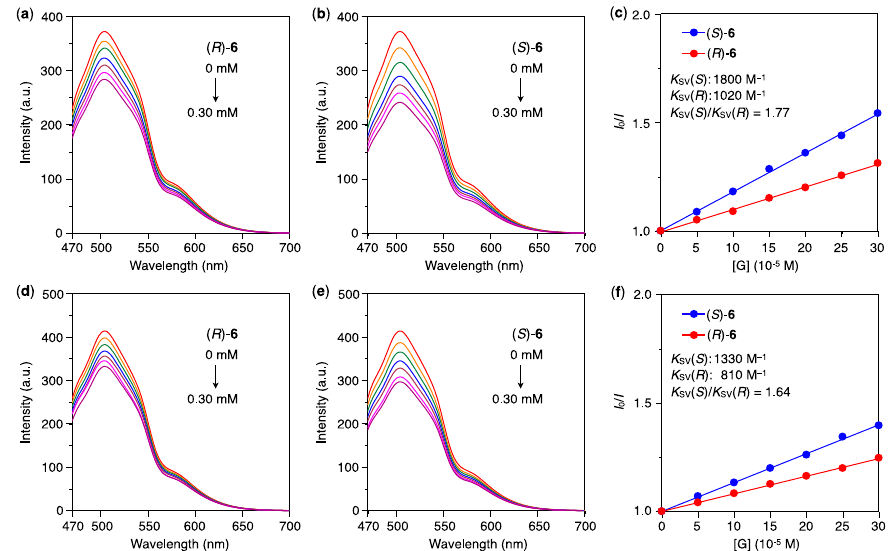
Figure 5. Fluorescence spectra of Am- 1b ( a , b ) and CyD- 1b ( d , e ) upon the addition of various amounts of ( R )- 6 ( a , d ) and ( S )- 6 ( b , e ) in hexane/THF (90/10, v / v ) at room temperature. [Glucose unit] = 1.0 × 10 − 5 M, [ 6 ] = 0–0.30 mM, λ ex = 450 nm; ( c , f ) Stern–Volmer plots for the fluorescence quenching of Am- 1b ( c ) and CyD- 1b ( f ) by ( R )- 6 (red) and ( S )- 6 (blue).